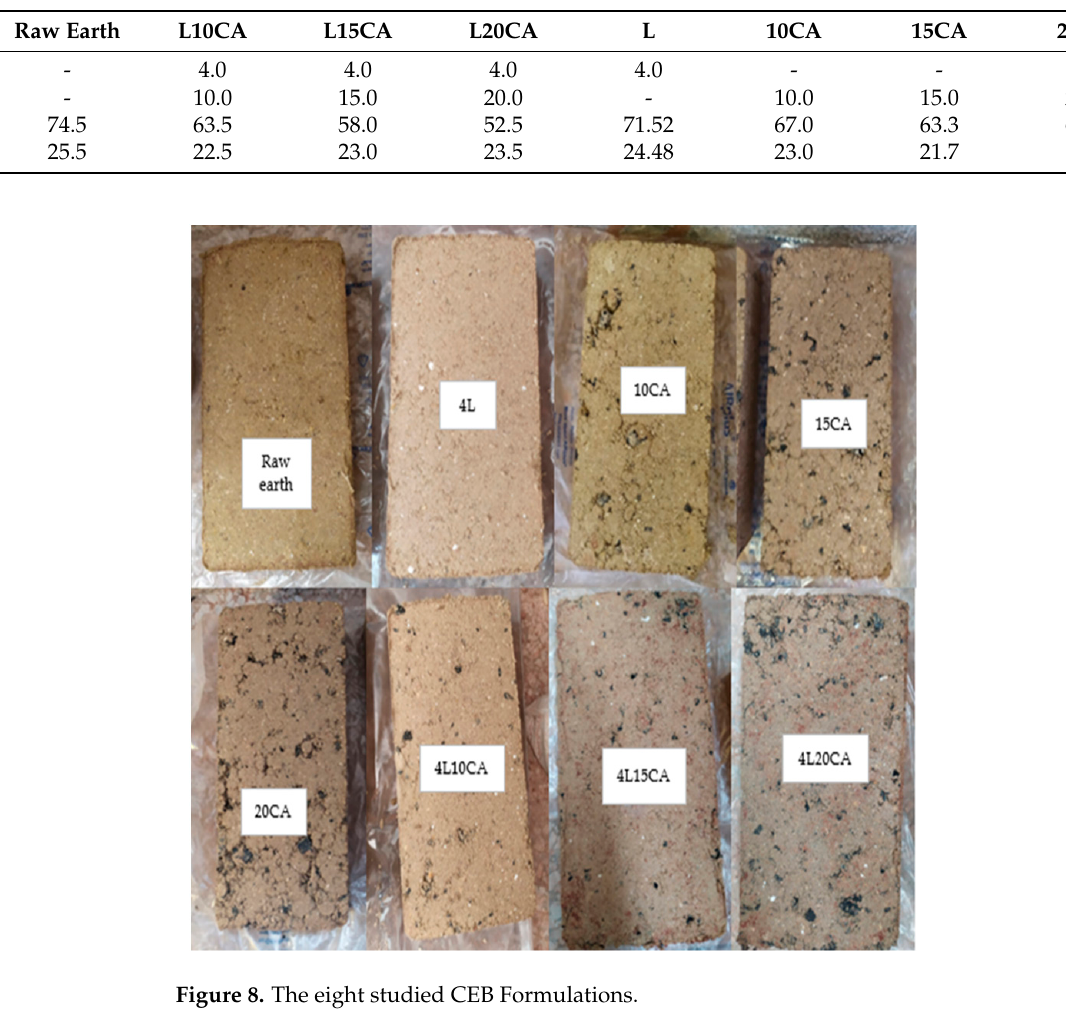
Figure 8. The eight studied CEB Formulations. Table 3. Formulations